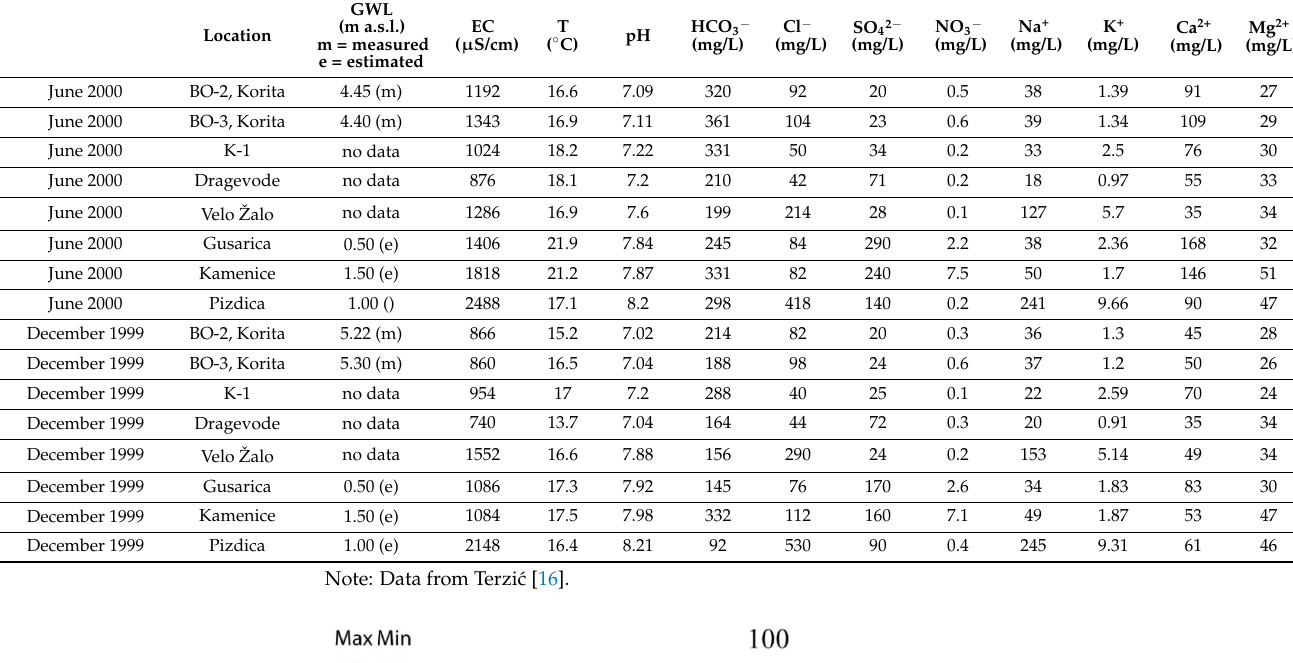
Table 3. Basic ion composition of the spring and wells on Vis Island.